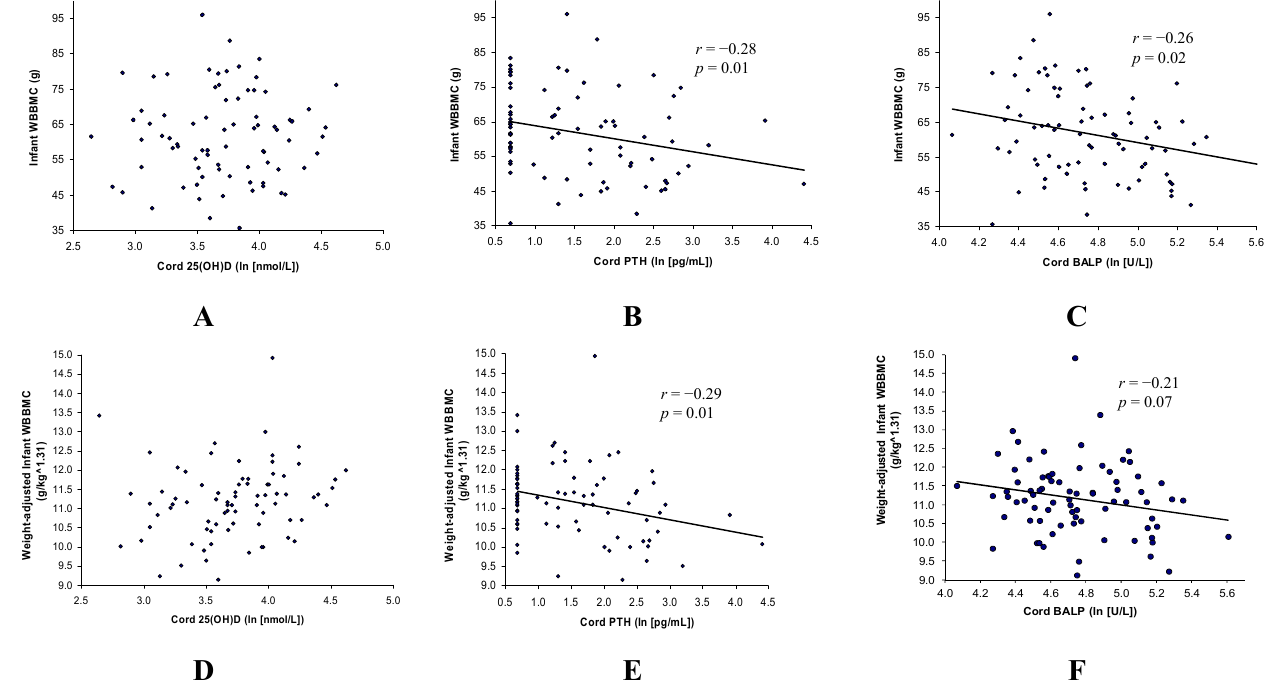
Figure 1. Associations of unadjusted ( A – C ) and weight-adjusted ( D – F ) infant whole body bone mineral content (WBBMC) with cord serum 25(OH)D, parathyroid hormone (PTH), and bone specific alkaline phosphatase